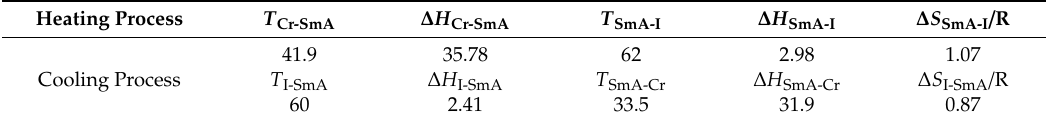
Figure 3. Optical photomicrographs under polarized optical microscopy (POM) of the compound I during the cooling scan. ( a ) Crystal phase at 20 °C and ( b ) SmA phase at 37.0 °C. Table 1. Phase transition temperatures (°C), enthalpy of transition ΔH (kJ/mol), and normalized entropy of transition, ΔS /R for compound I upon heating/cooling cycles.